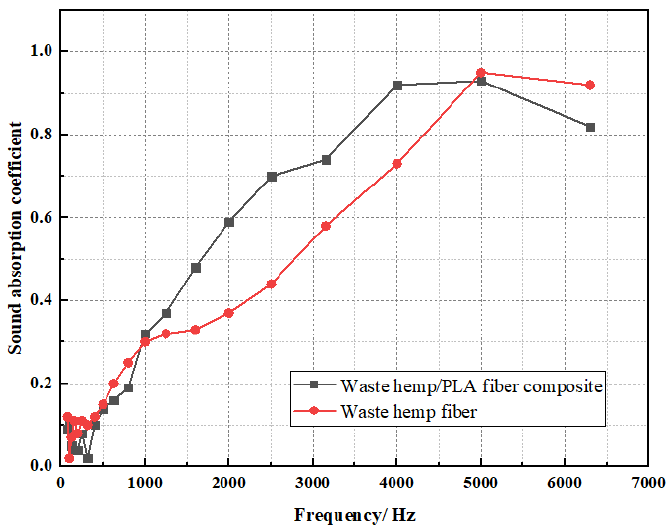
Figure 9. The sound-absorbing coefficient curve of waste hemp/PLA fiber composite and waste hemp fiber.